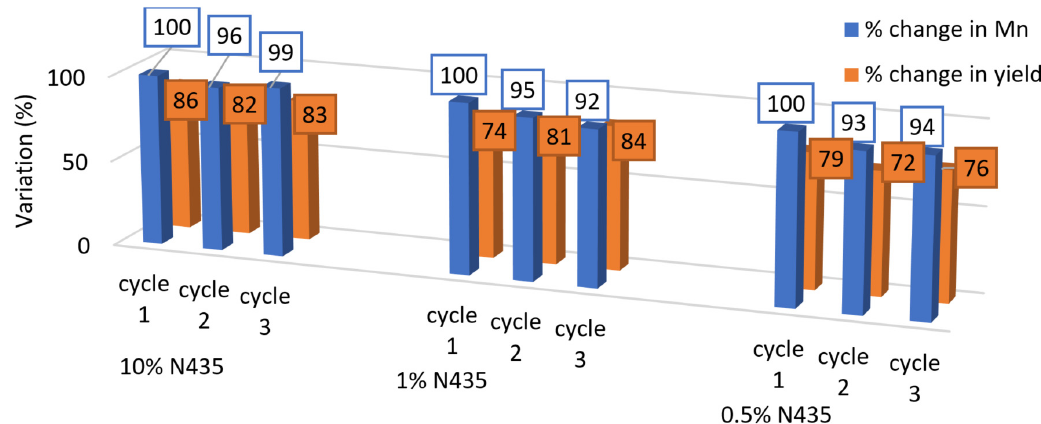
Figure 6. Effect of recycling 0.5%, 1% and 10% N435 on M n and yield in bulk conditions.